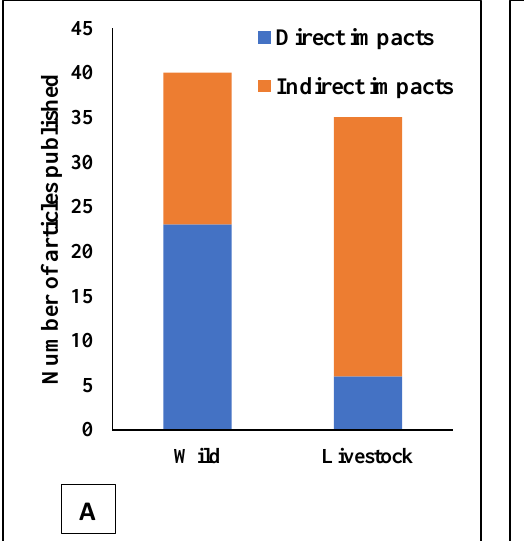
Figure 2. The distribution (by percentage number of papers, n = 69) of researches by countries which reported ungulate impacts on/interactions with reptiles. The remaining four papers are accounted for the review studies which did not specify the geographical location of the study.